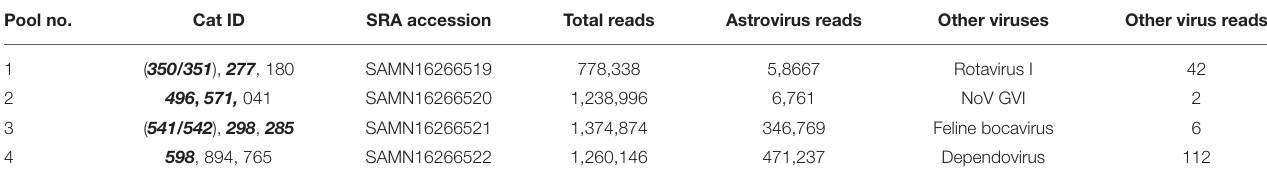
TABLE 1 | Virus metagenomics analysis of four pools of fecal samples. Pool